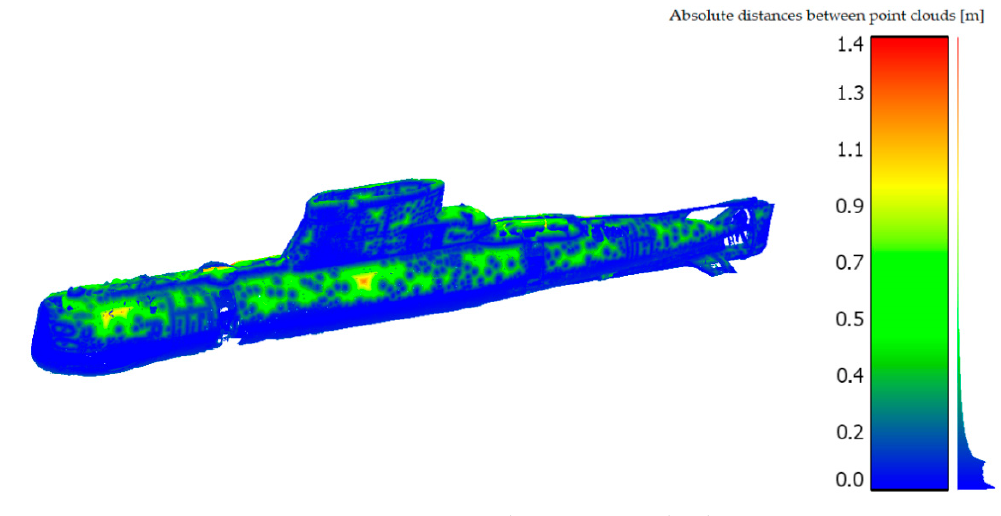
Figure 13 . Distances between point clouds .